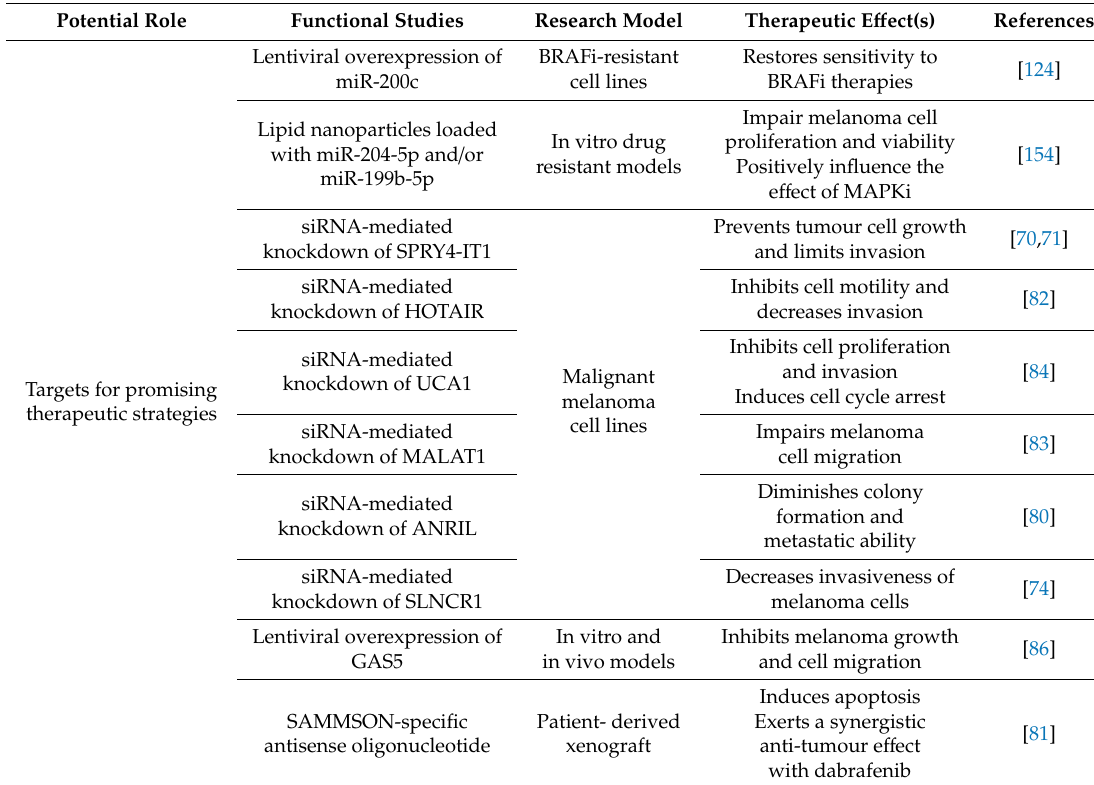
Table 4. Promising results that recommend non-coding RNAs as therapeutic targets for potential clinical